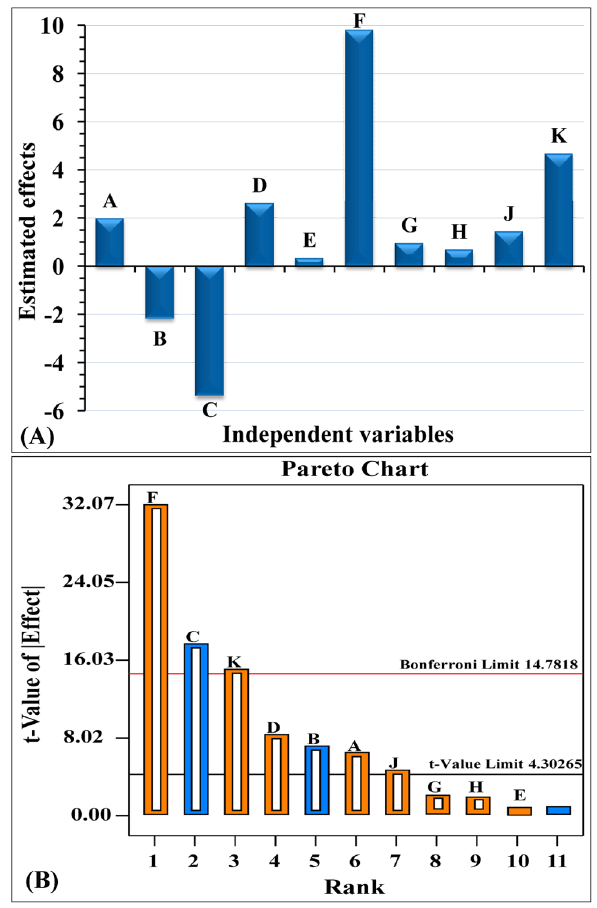
Figure 3. (A ) Estimated effects of independent factors on BNC production by Bacillus tequilensis strain SEE-12 using Plackett–Burman design, ( B ) Pareto chart shows the order and significance of the